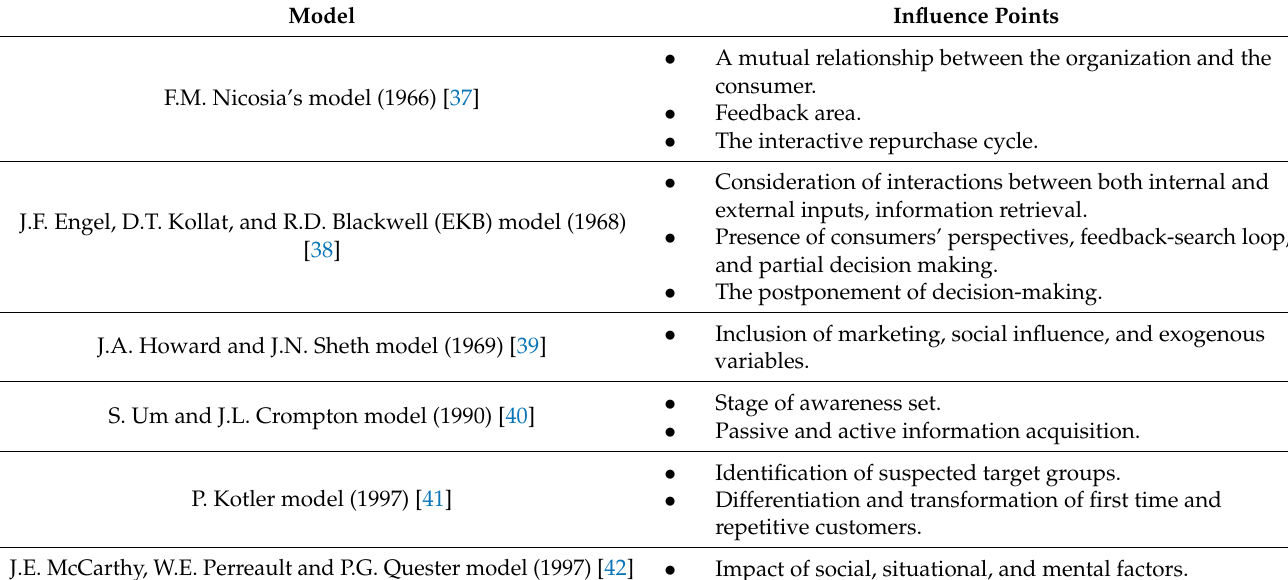
Table 1. The influence of the main CDM models on digitalized insurance decision-making processes. Source: created by the authors, following